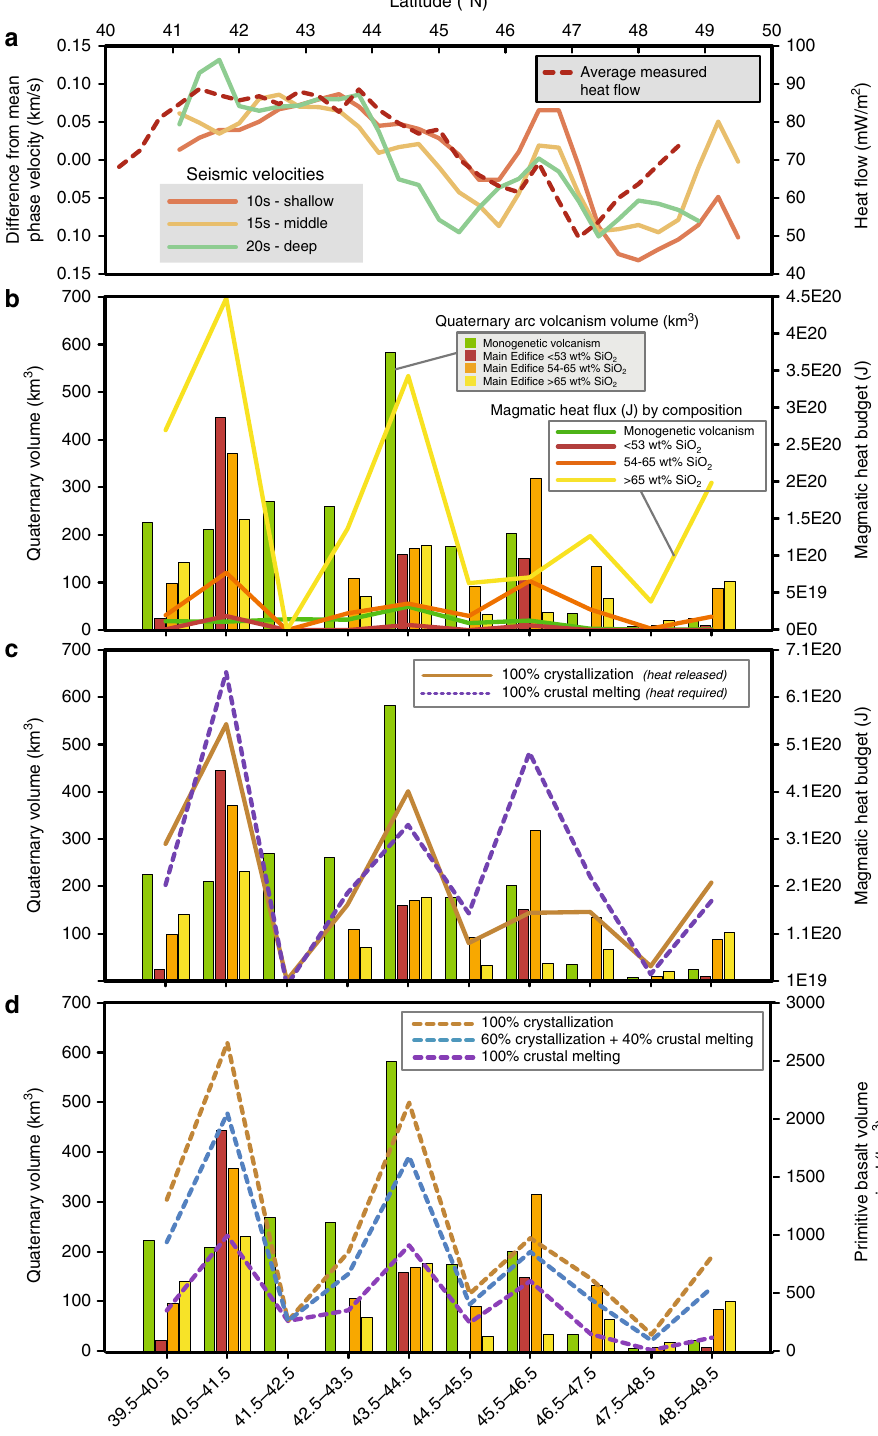
Fig. 4 Results of our heat and fl ux calculations. a Earthquake and ambient noise seismic phase velocities from Janiszewski 51 and measured heat fl ow from Ingebritsen and Mariner 86 . b Histogram of the quantity and composition of Quaternary arc volcanism plotted in 1° latitude bins (i.e., samples in 40.5 – 41.5° N plotted in the associated histogram bin) and the calculated magmatic heat budget (curves) required to generate each compositional category by pure fractional crystallization following the methods described in text. Note the dominant role of silicic magma generation in the overall heat budget. c Calculated magmatic heat budget (curves) required to generate Quaternary Cascades volcanism (histogram) by 100% fractional crystallization vs. 100% crustal melting. d Volume of mantle basalt (curves) required to generate Quaternary Cascades volcanism (histogram) via varying amounts of crystallization and crustal